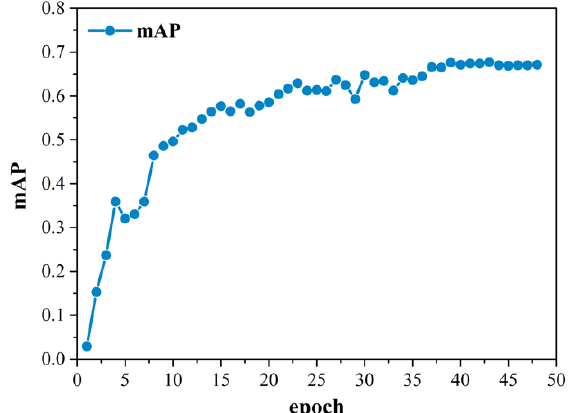
Figure 8. The mAP curve of the experiment in this paper when epoch is 48.